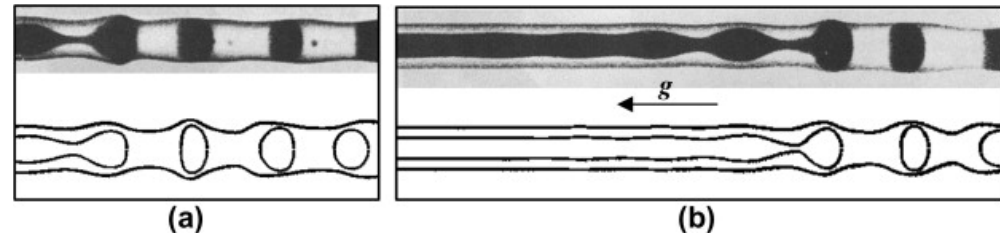
Figure 3. A comparison between experimental jets of Hertz and Hermanrud [3] (top section) and the computed jet (bottom section) profiles at computational time: ( a ) τ = 251 and ( b ) τ = 253. The parameter used to generate the figures, calculated based on the inner most fluid, are Re = 75, We = 6, Fr = 5442, ρ 21 = 1, µ 21 = 1, σ 21 = 0.38, U 21 = 1, U 31 = 0, R 21 = 2, for both experimental and computed jets. ρ 31 = µ 31 = 0.05 is for the computed jet; ρ 31 = 0.001 for the experimental jet. The figure is taken from